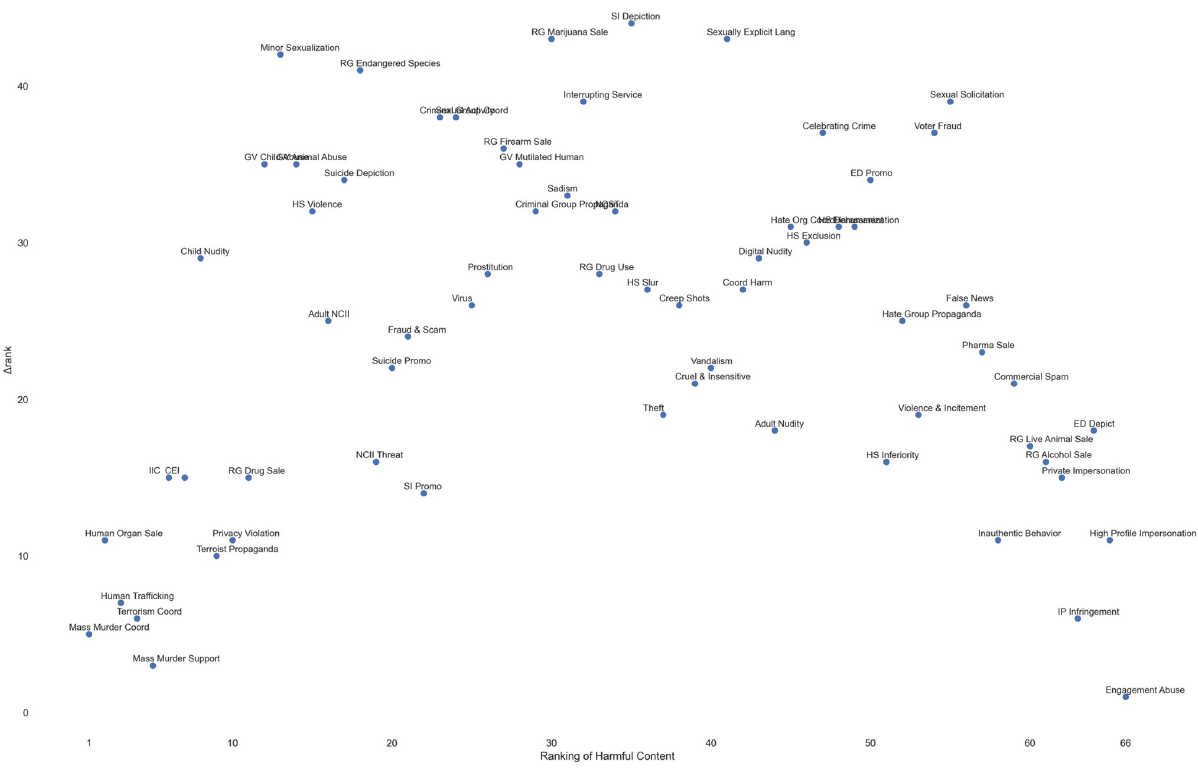
Fig 6. Harmful content’s Δ rank vs. sample-wide ranking.